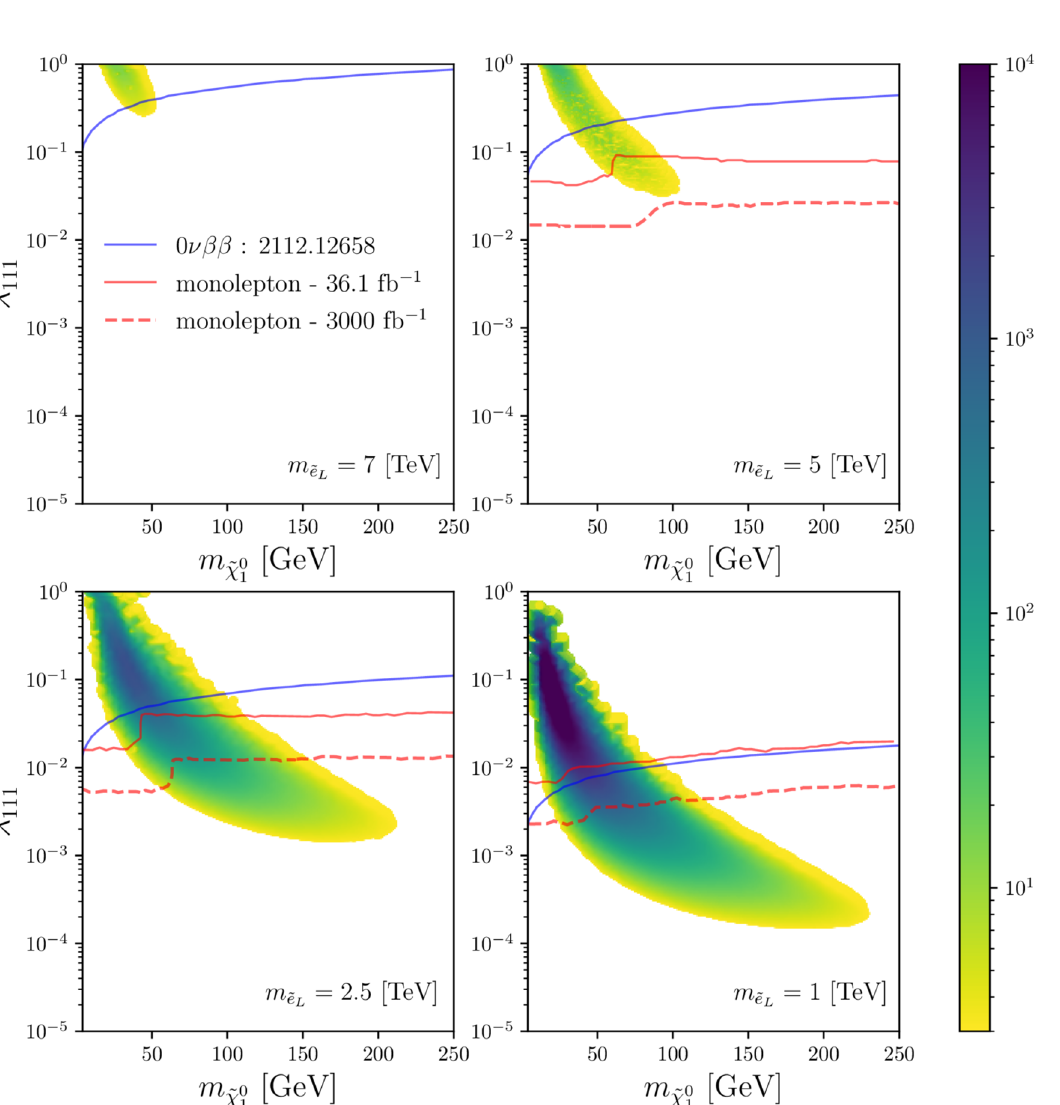
vs. m plane with the proposed DV search strategy with Figure 5 . Sensitivity reach in the λ 0 ˜ χ 0 1 111 3000 fb − 1 . The number of expected signal events depicted in the color bar starts from 3. Red lines show the recast monolepton limits for 36.1 fb − 1 (solid red line) and our high-luminosity LHC projection to 3000 fb − 1 (dashed red line). Constraints from 0 νββ are shown in solid